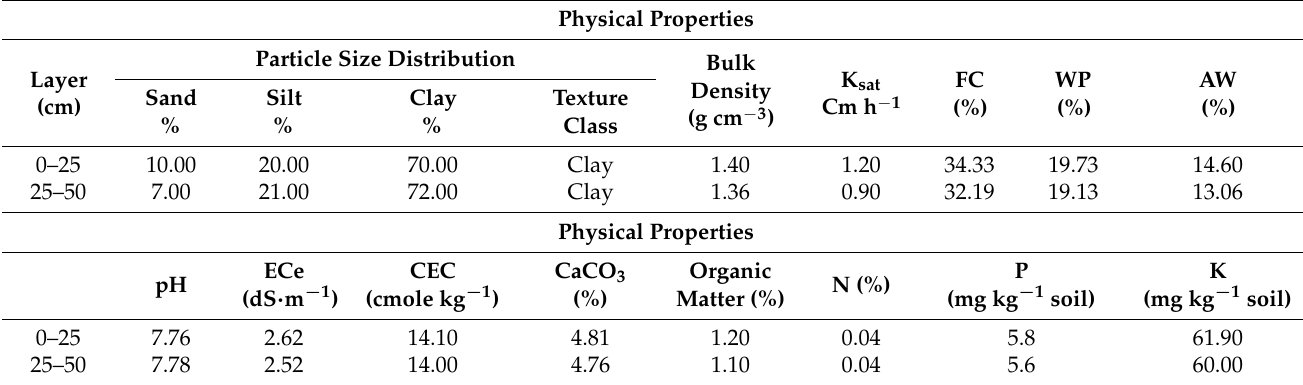
Table 2. Some initial physical and chemical properties of the experimental